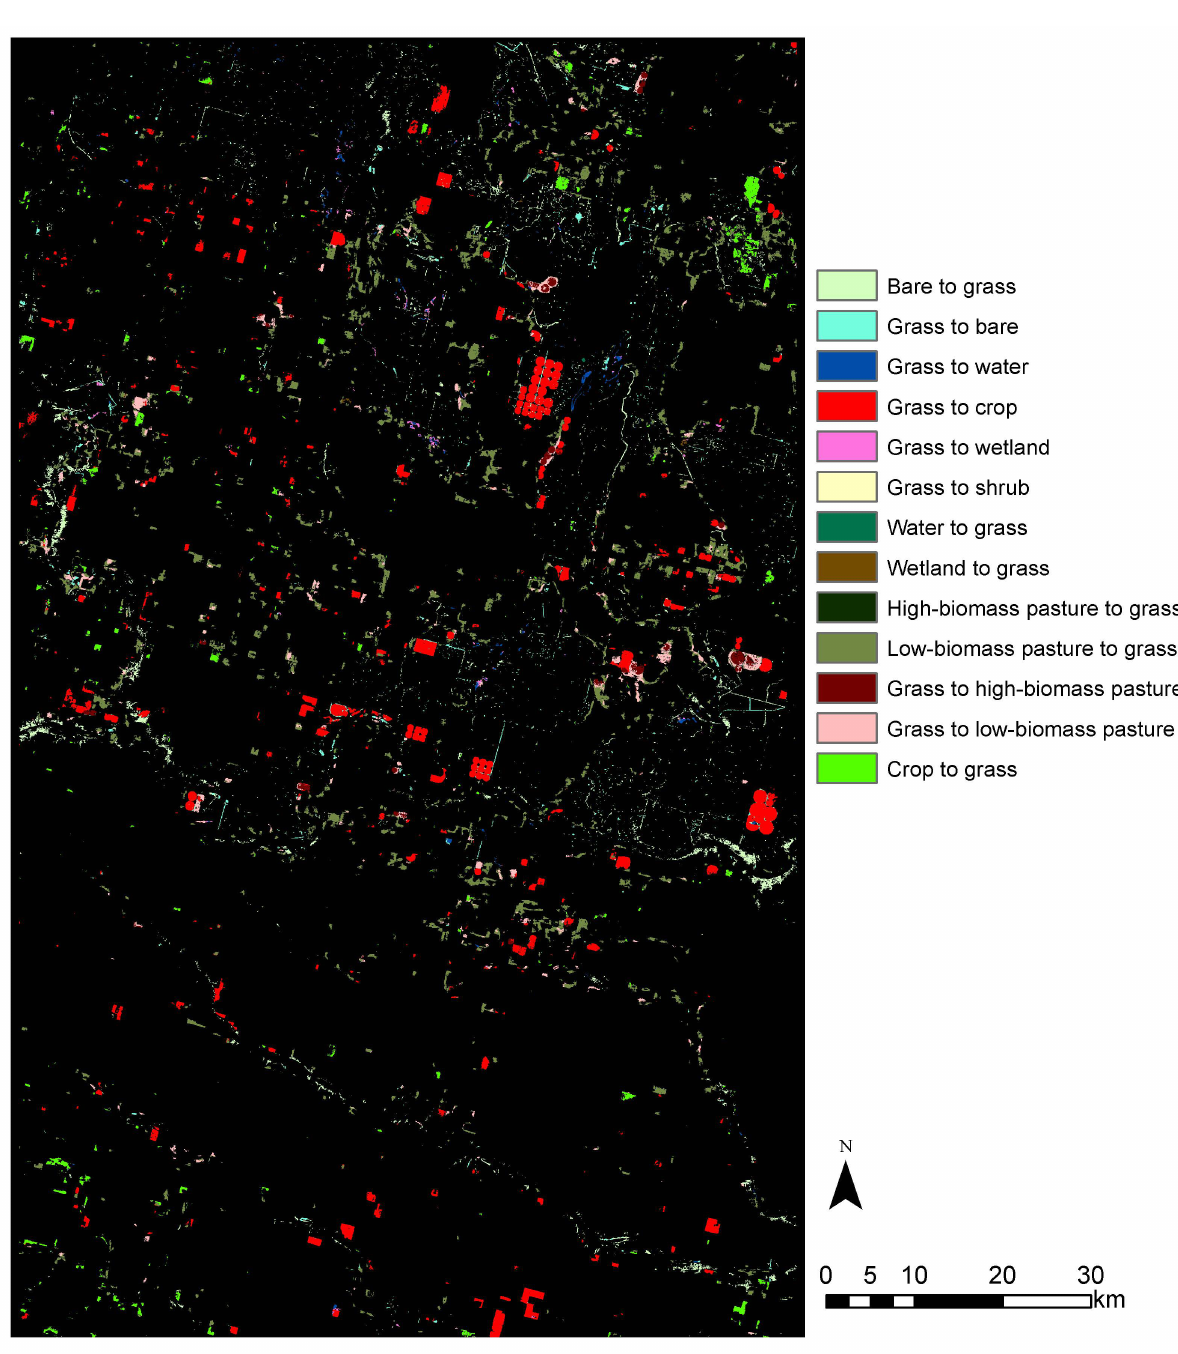
Figure 8. Grassland loss and gain in the south-west study region from 1984 to